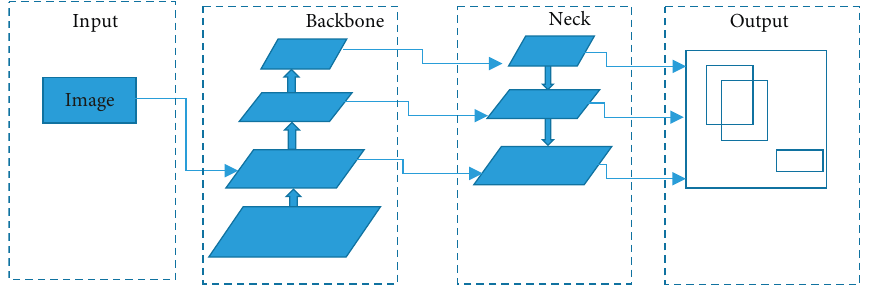
Figure 15: YOLO: single-stage architecture